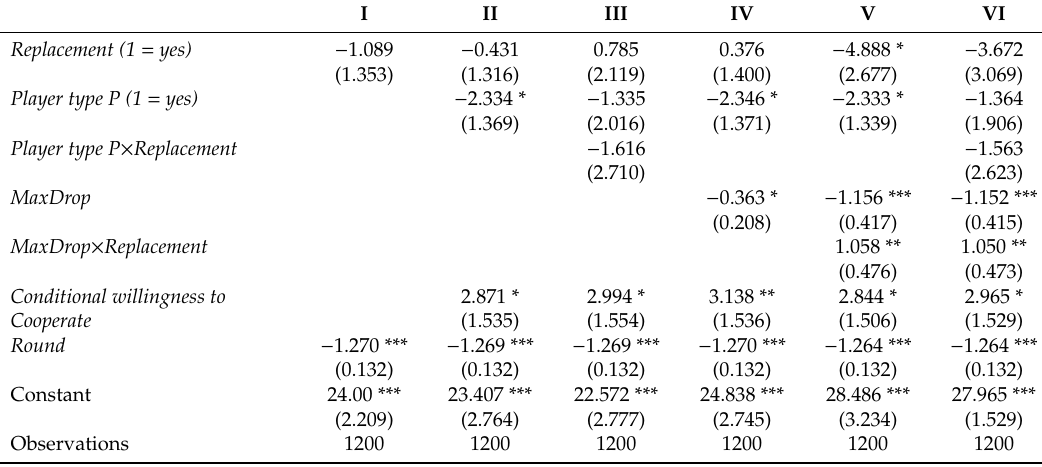
Table 9. Tobit estimations on individual contributions in part II ( Endo